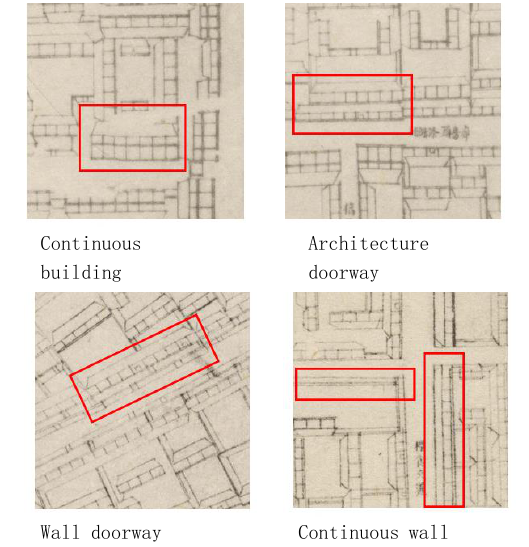
Figure 7. Four ways of building expression along the streets in the Qianmen